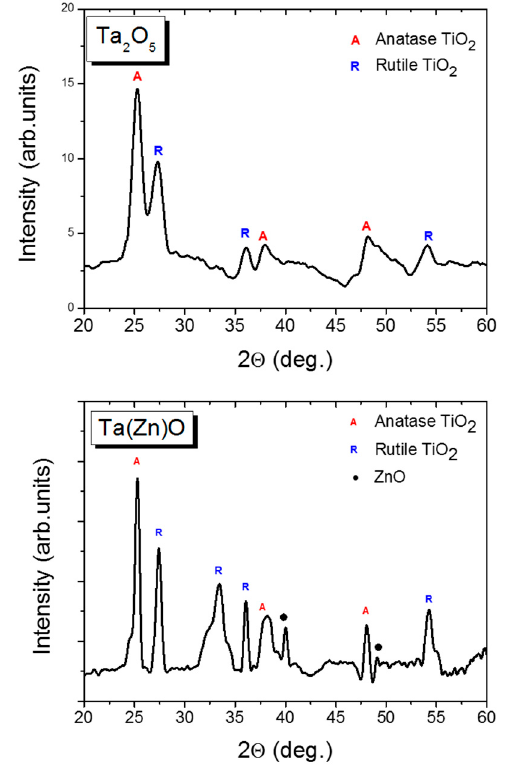
Figure 5. X-Ray diffraction spectra of the Ta 2 O 5 and Ta(Zn)O coated Ti with PEO surface pretreatment. Figure 5. X-Ray di ff raction spectra of the Ta 2 O 5 and Ta(Zn)O coated Ti with PEO surface